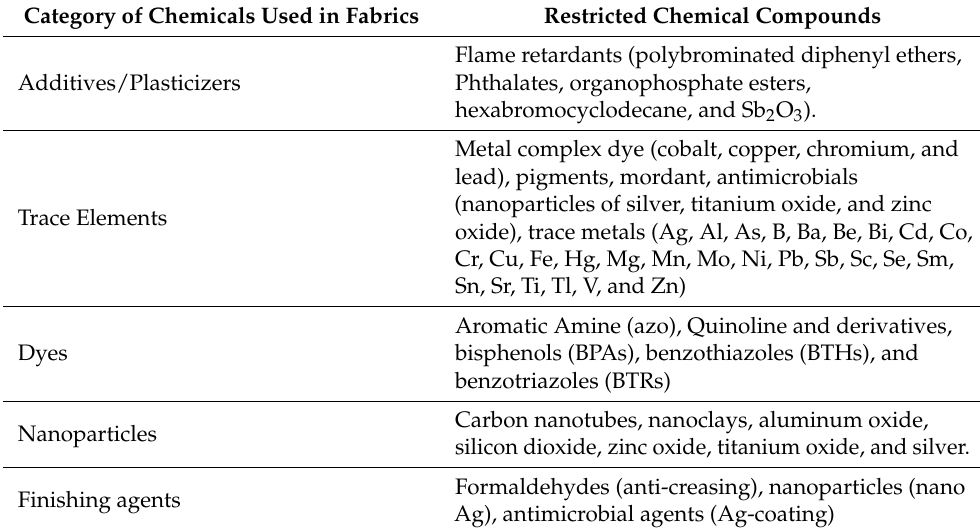
Table 2. Harmful chemicals used in fabrics